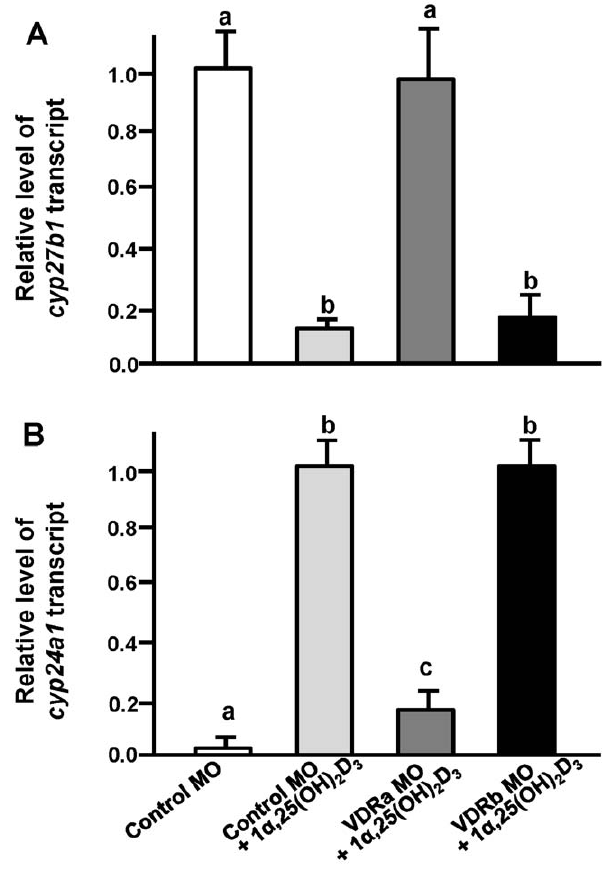
Figure 7. Effects of vitamin D receptor (VDR)a and VDRb morpholino oligonucleotides (MOs) on cyp27b1 and cyp24a1 mRNA expressions in 3-d post-fertilization (dpf) zebrafish embryos treated with 1 a ,25(OH) 2 D 3 (20 m g/l). (A) cyp27b1 mRNA expression. (B) cyp24a1 mRNA expression. mRNA expressions were analyzed by a qPCR using b -actin as the internal control. Different letters indicate a significant difference ( p , 0.05) using one-way ANOVA followed by Tukey’s multiple-comparison test. Values are the mean 6 SD. ( n =5–6).